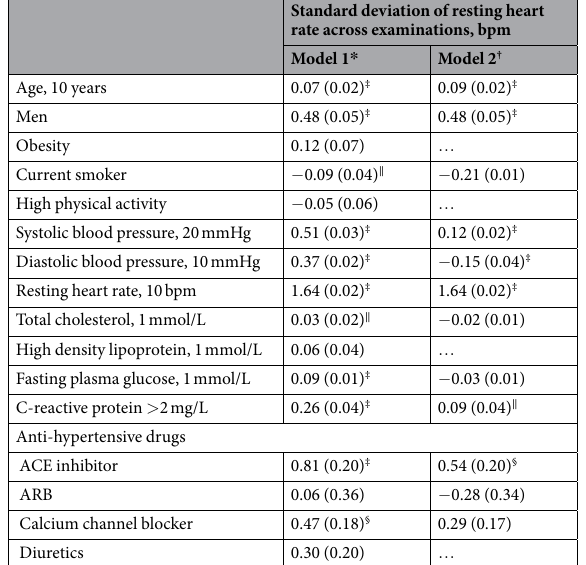
Table 2. Standard deviation of resting heart rate associated with participant characteristics. Numbers in the table indicate β (standard error). All the characteristics were collected at the 3 rd examination in the Kailuan Study (2010–2011). * Adjusted for age and gender. † Adjusted for all variables associated with standard deviation of resting heart rate in Model 1. ‡ P < 0.001; § P < 0.01; ‖ P < 0.05.